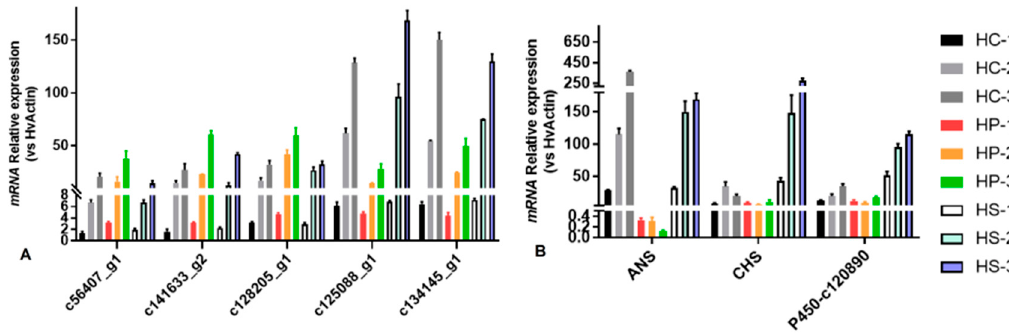
Figure 3. Validation of DEGs by qRT-PCR. ( A ) Five DEGs were randomly selected to verify the accuracy and reliability of the transcriptome sequencing results in the flower bud stage. ( B ) The expression of CHS, ANS, and P450-c120890 in different flowering stages. The expression of actin was used as an internal control. Data represent the mean ± SD of three independent experiments.